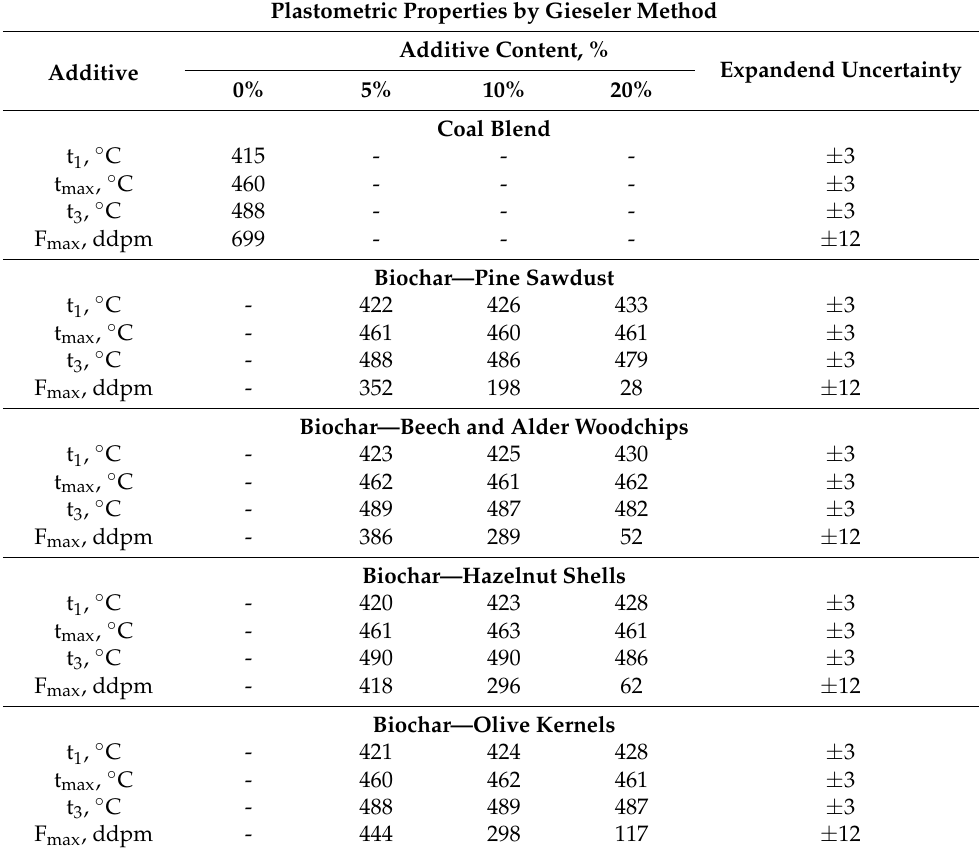
Table A3. The influence of carbonized biomass supplementation on Gieseler plastometric